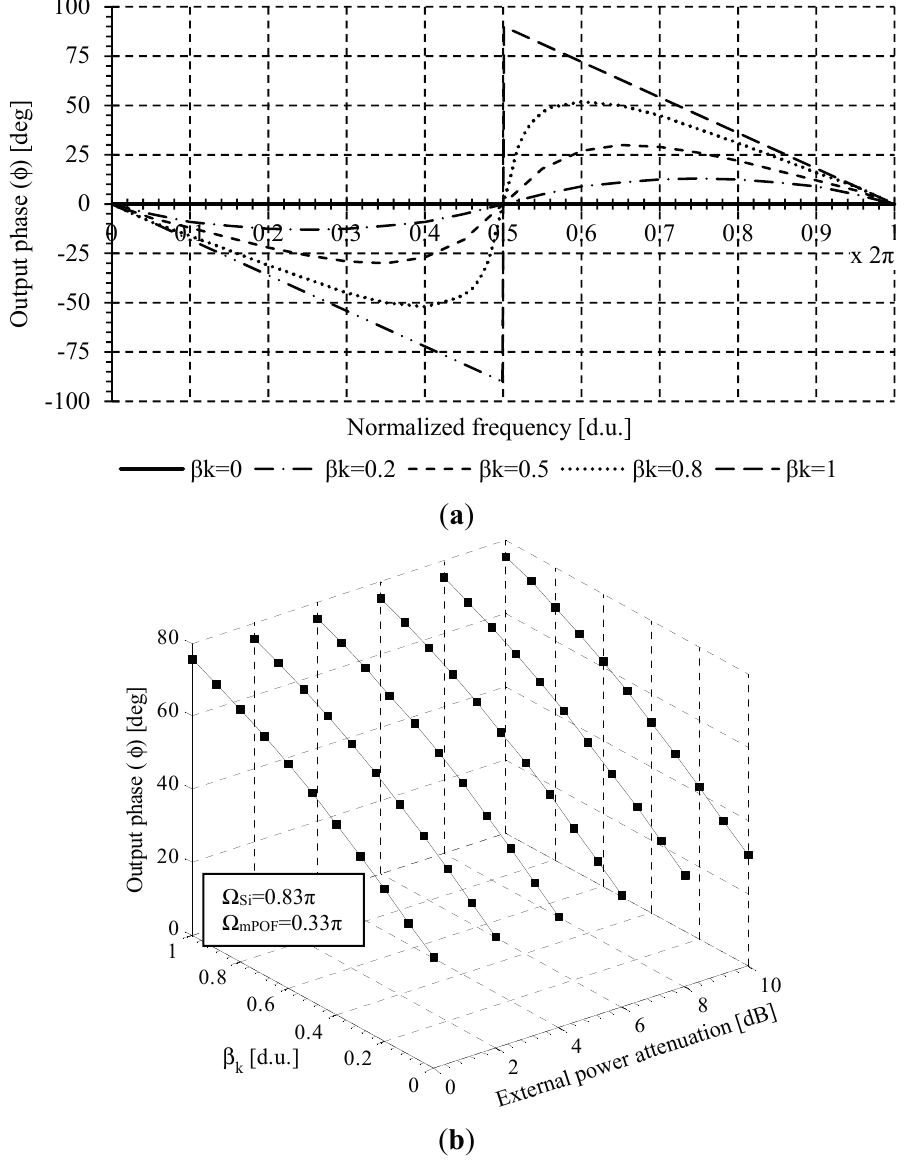
Figure 2. ( a ) Normalized phase response of the transfer function of the self-referencing configuration versus angular frequency for different values of β k ; ( b ) Theoretical curves of the output phase φ k versus β k for different external power fluctuations at the reception